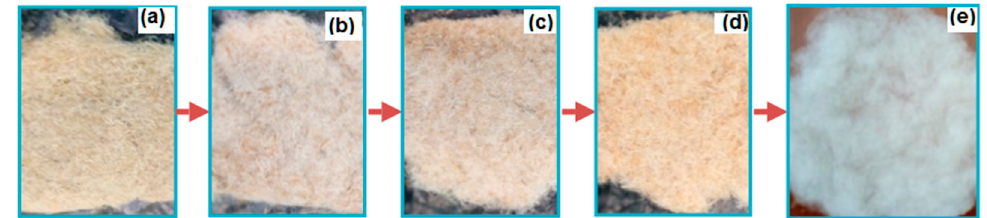
Figure 5. Images of ( a ) non-retted, ( b ) retted, ( c ) dewaxed, ( d ) alkalized, and ( e ) bleached fibers.